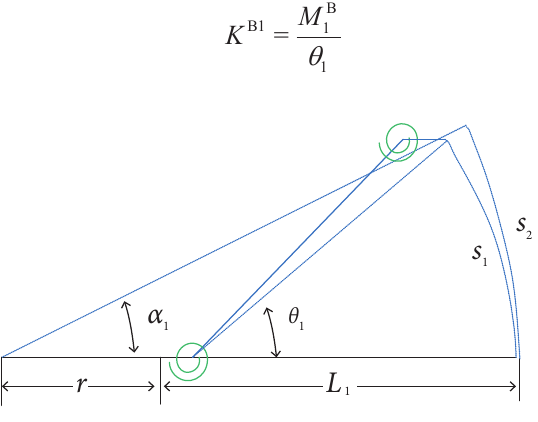
Figure 5. The Pseudo-rigid-body Model of Beam 1.